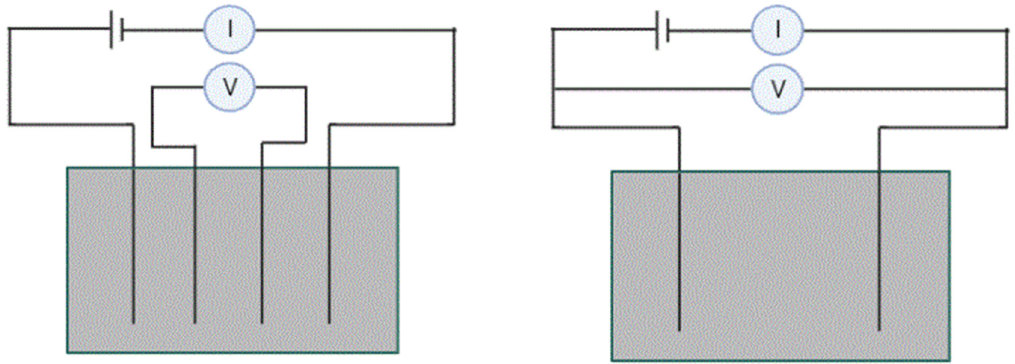
Figure 6. Four-probe and two-probe configurationsin concrete.